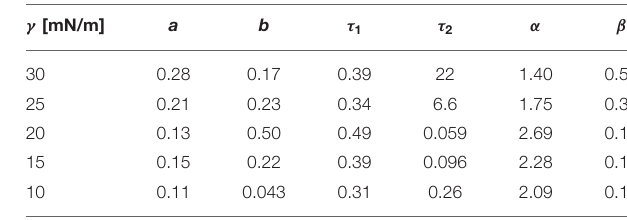
TABLE 1 | Fitting parameters for F ( t ) (see Equation 9) to the autocorrelation functions of the total flow for different values of γ .